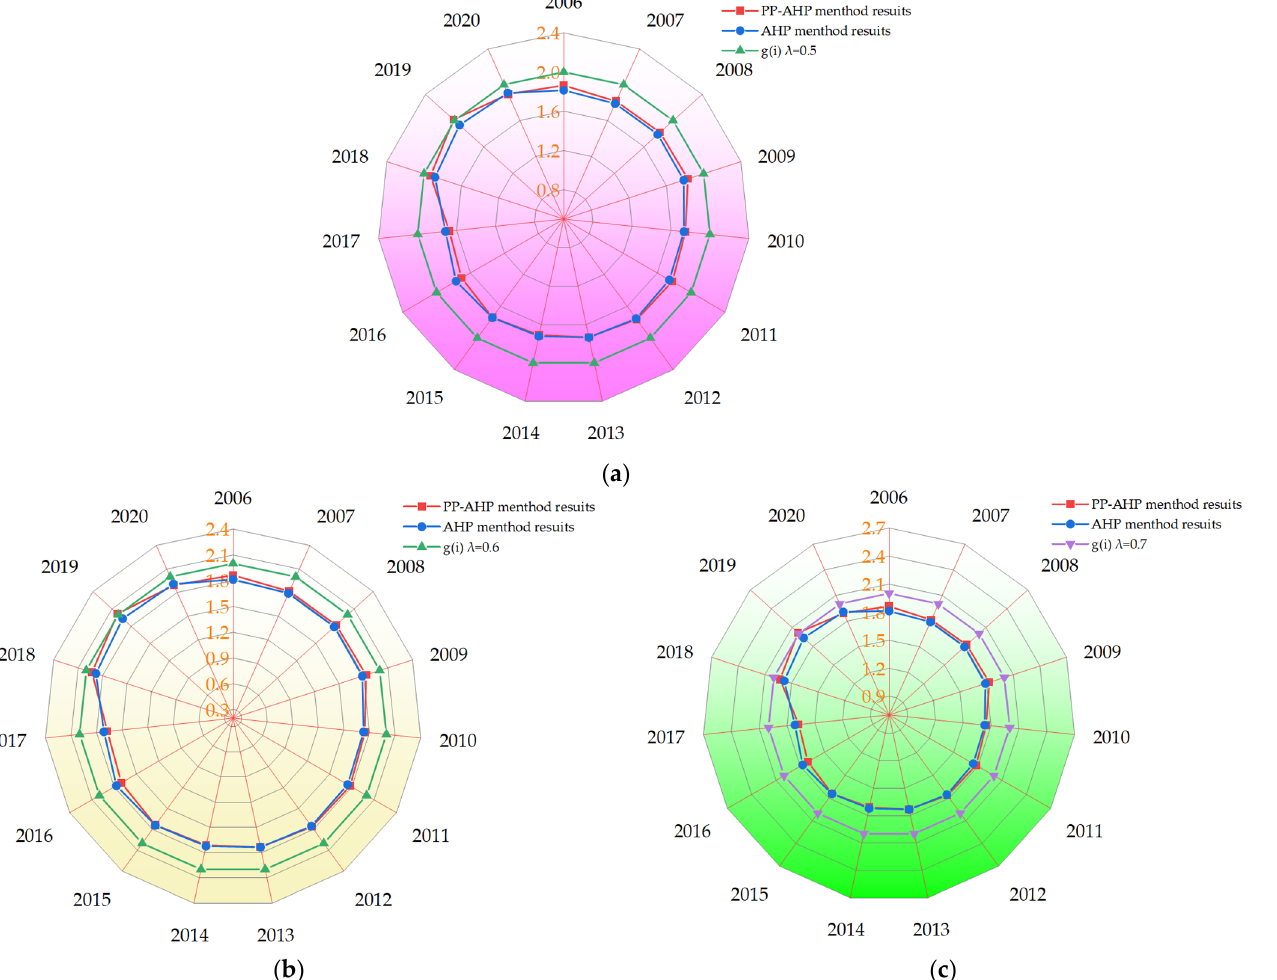
Figure 6. A comparison of the AHP method, PP-AHP method, and confidence level judging method; ( a – c ) are radar plots of the results of the confidence level judging method, compared with the results of the two weighting methods, when the confidence levels are taken to be λ = 0.5, λ = 0.6 and λ = 0.7.